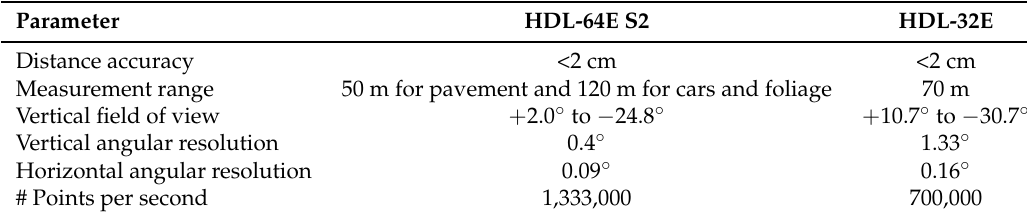
Table 1. The specifications of the